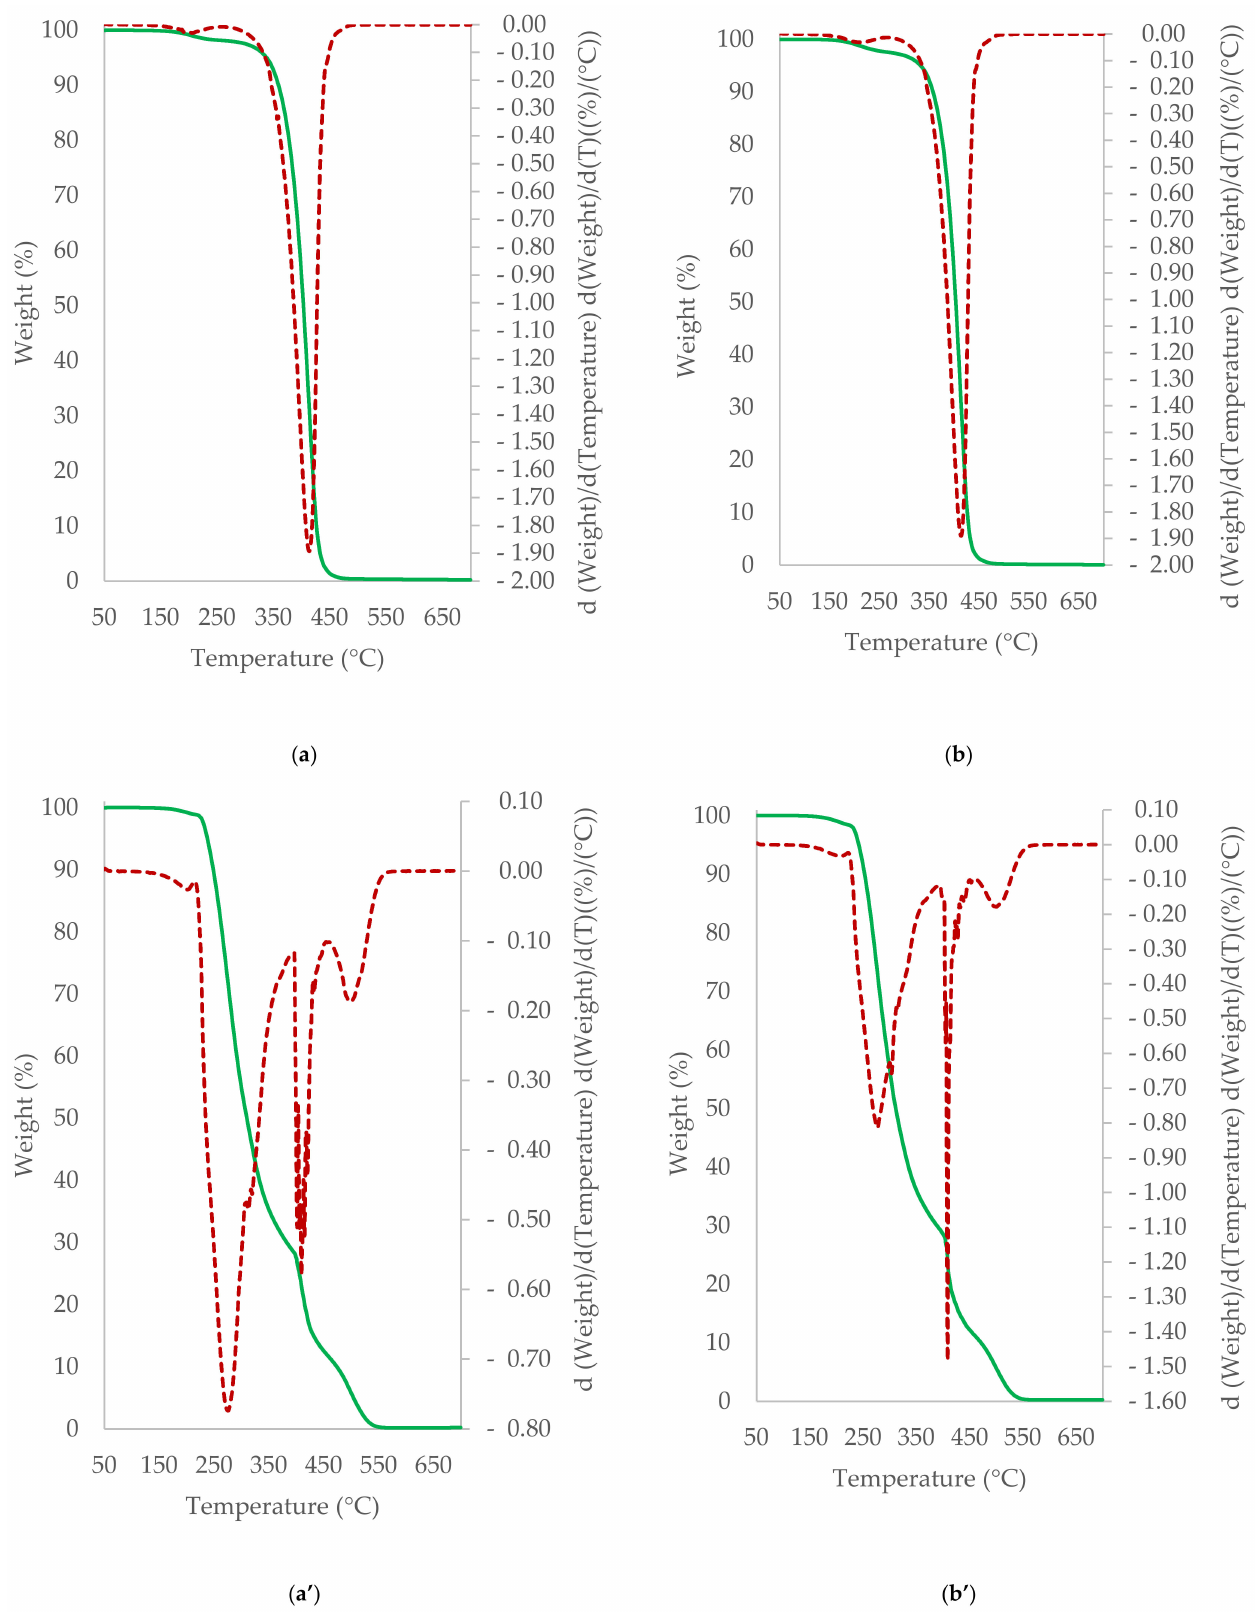
Figure 6. TGA and DTG curves of fats extracted from cocoa beans Forastero (Ecuador), unroasted ( a ) in nitrogen ( a’ ) in oxygen and roasted ( b ) in nitrogen and ( b’ ) in